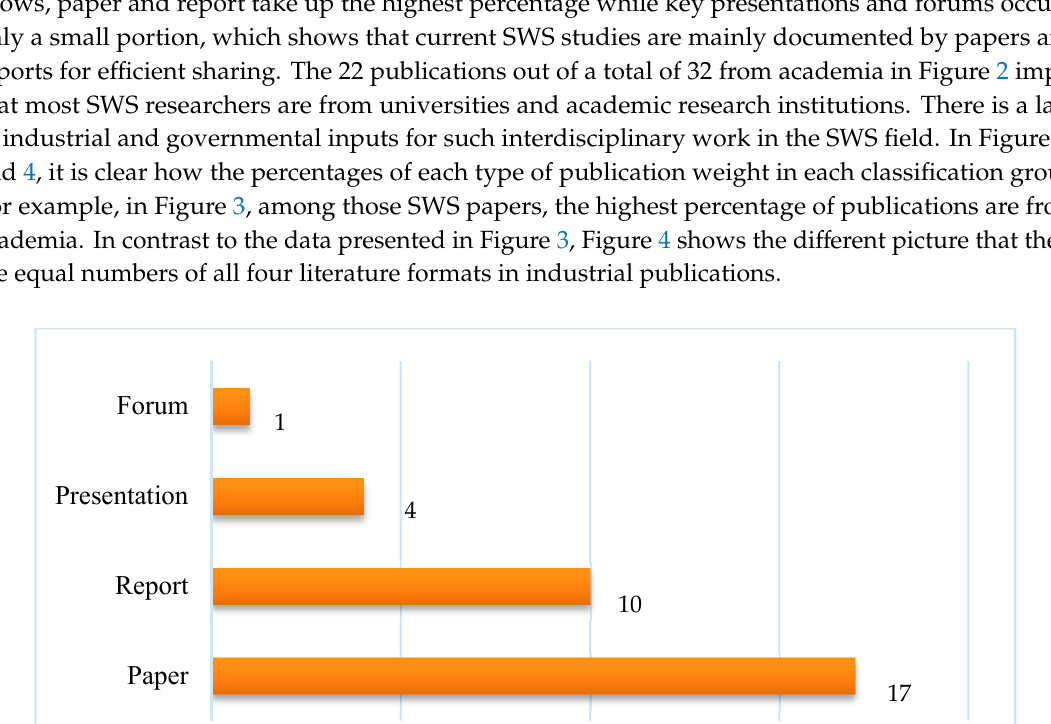
Figure 1. Literature overview: the number of publications for smart water systems (SWS’s) definition.